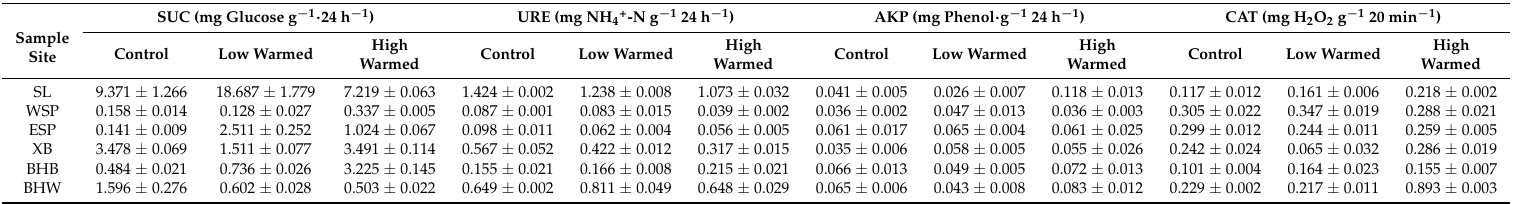
Note: Values are the mean ± standard error.